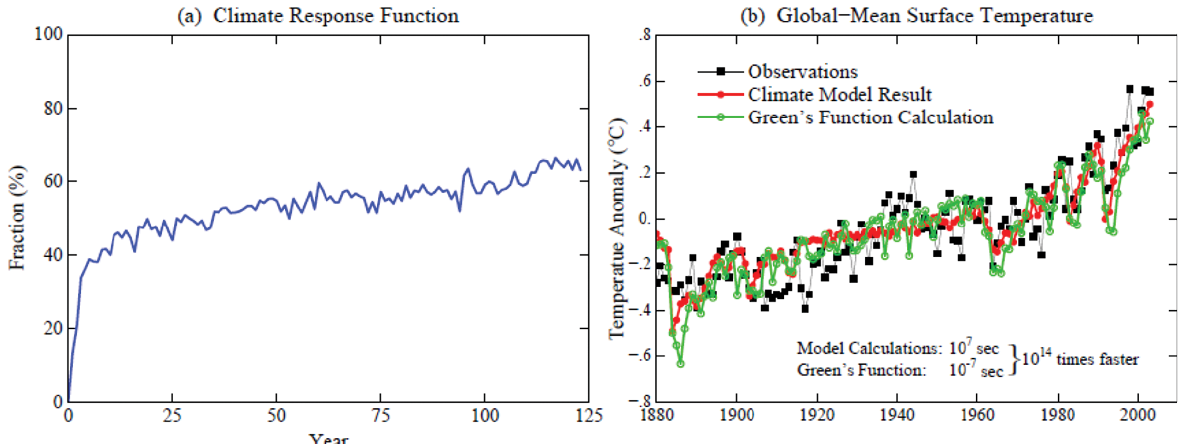
Fig. 4. (a) First 123yr of climate response function, from Fig. 3, (b) comparison of observed global temperature, mean result of 5-member ensemble of simulations with the GISS global climate modelE-R, and the simple Green’s function calculation using the climate response function in (a)